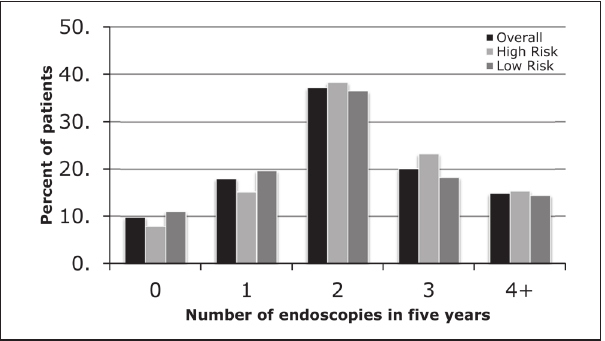
Figure 6) The number of endoscopies received in the five-year follow-up period, stratified according to high and low risk for recurrence